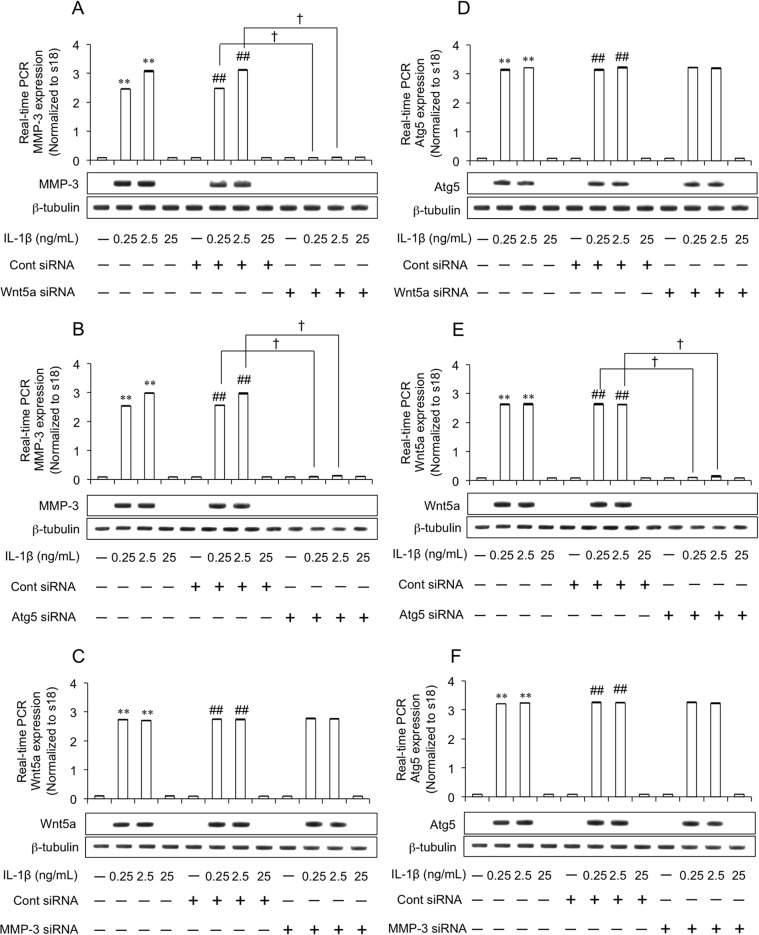
Determination of the signaling sequence using specific siRNAs.(A–F) Cells were incubated in serum-free medium for 24 h and then treated with IL-1β (0, 0.25, 2.5 and 25 ng/mL) and Atg5, Wnt5a, or MMP-3 siRNAs. mRNA expression levels of Atg5, Wnt5a and MMP-3 relative to the control (18S rRNA) were determined by qPCR and western blotting for LC3, Atg5, Wnt5a, and MMP-3 (lower row). β-tubulin was used as a housekeeping protein in western blots. **P < 0.01 vs. control; ##
P < 0.01 vs. control siRNA; †
P < 0.01, as indicated by the bracket.